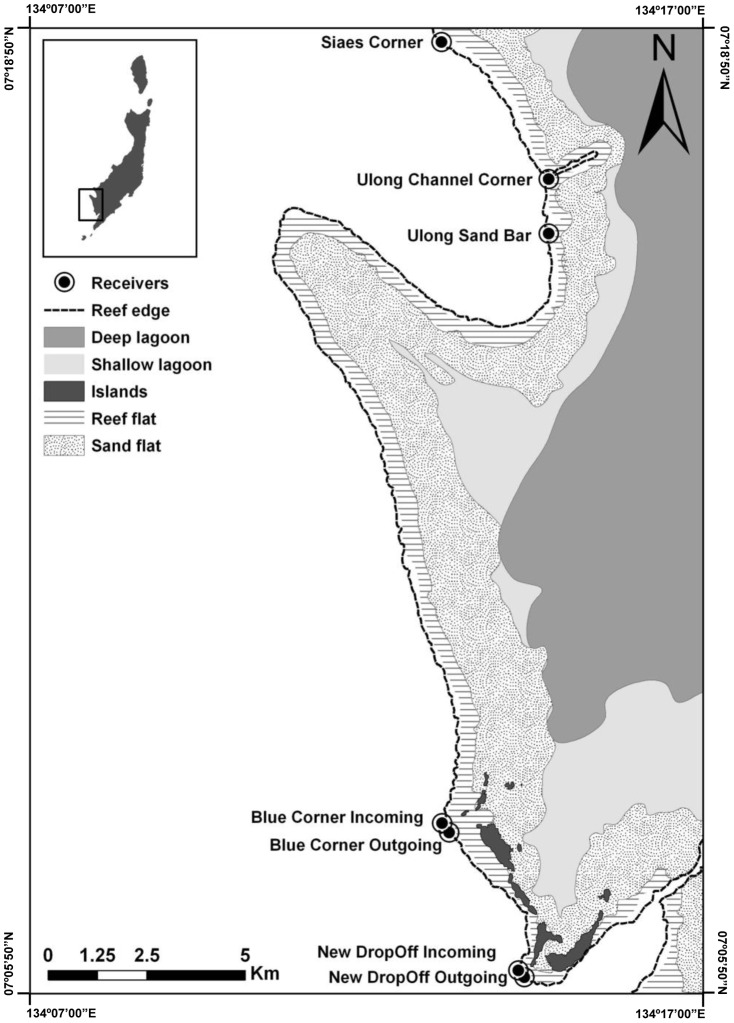
Study area in Palau.Outer reef slope of the southwest barrier reef of Palau, showing location of receivers. Top left box indicates the study site in the main island platform. The “shallow lagoon” shade represents depths down to 5 m, while “deep lagoon” areas might reach depths of 20 m.